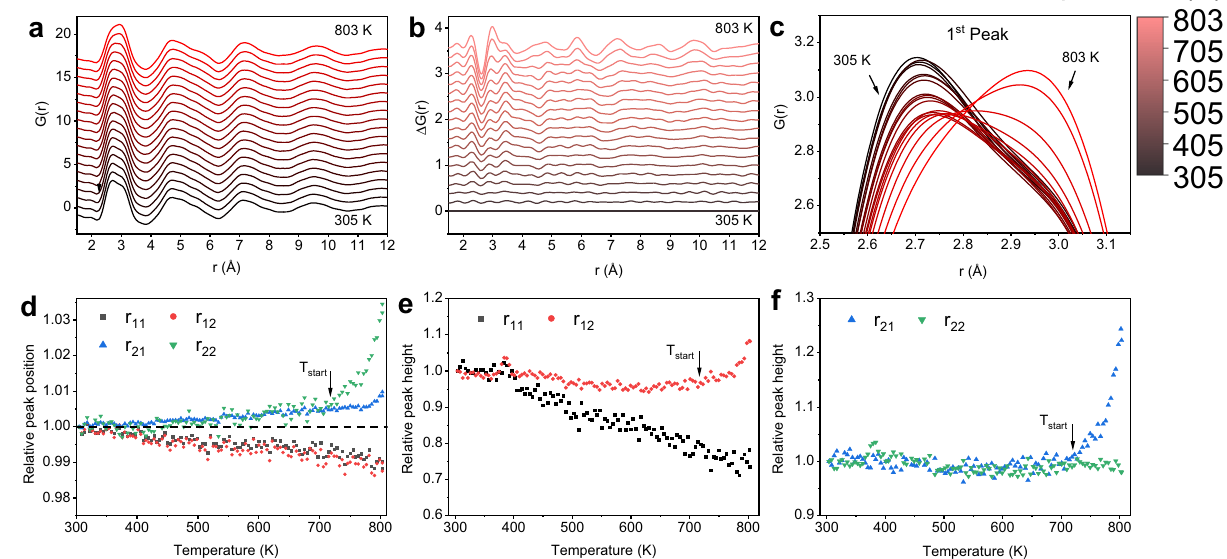
Fig. 4 In-situ X-ray diffraction results in real space. a Evolution of the reduced pair-distribution functions G ( r ) of the as-prepared sample during heating. b The respective differences in the reduced pair-distribution functions obtained by subtracting the reference pattern at T = 305 K. c The enlarged image of the evolution of the fi rst peak as a function of temperature. d Evolution of the peak positions of the fi rst and second peaks as a function of temperature. e Evolution of the peak intensities of the sub-peaks of the fi rst peak as a function of temperature. f Evolution of the peak intensities of the sub-peaks of the second peak as a function of temperature. The start temperature of the fi rst exothermic peak in the 30 K min − 1 DSC curve is denoted as T start . Both peaks are fi tted with two Gaussian